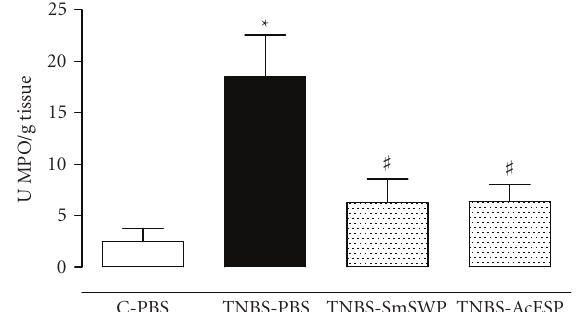
Figure 2: E ff ect of Schistosoma mansoni soluble worm proteins (SmSWPs) and Ancylostoma caninum excretory/secretory products (AcESPs) on myeloperoxidase (MPO) activity . MPO activity was measured to monitor the degree of myeloid cell infiltration in the colon. Data are presented as units MPO per gram of colon tissue and 1 unit equals the amount of MPO necessary to degrade 1 μ mol of H 2 O 2 to H 2 O per minute at 25 ◦ C. TNBS-induced colitis caused a significant increase in MPO activity compared to control mice treated with phosphate-bu ff ered saline (PBS). Intraperitoneal injection of helminth-derived products significantly ameliorated inflammation as shown by the significant decrease in MPO activity. Treatment of control mice with SmSWP or AcESP had no e ff ect (data not shown). ∗ p ≤ . 05, significantly di ff erent from contol PBS; # p ≤ . 05, significantly di ff erent from TNBS-PBS; two way ANOVA, n = 7 − 10